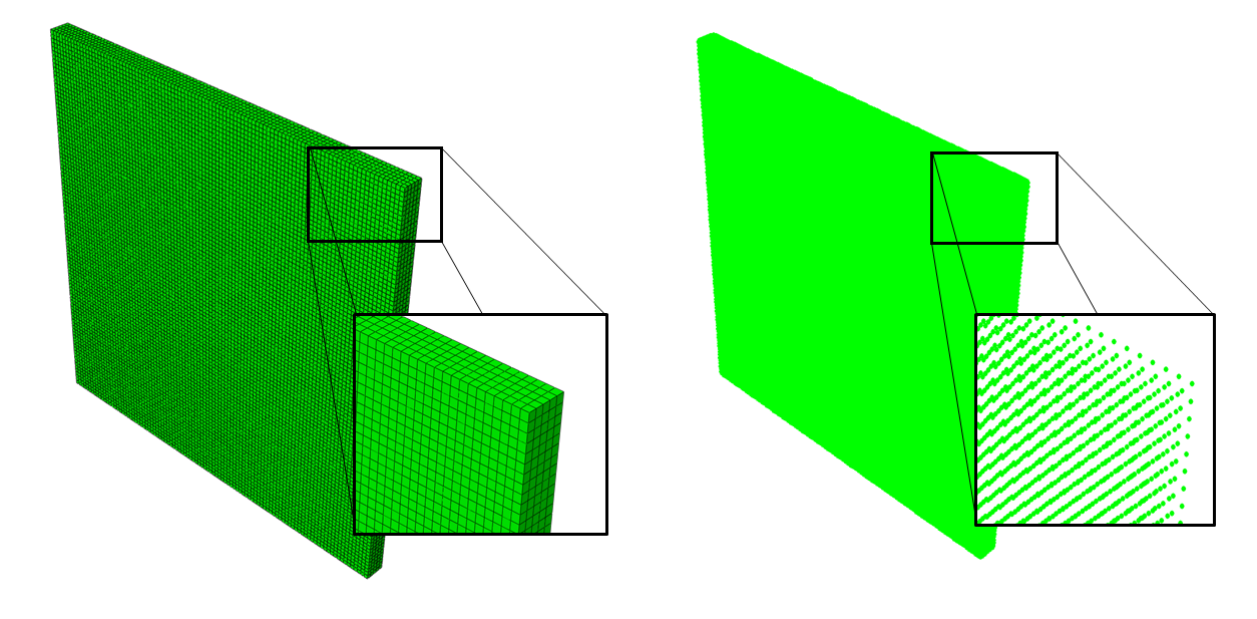
Figure 2. Traditional Grid Mesh versus Smoothed Particle Hydrodynamics